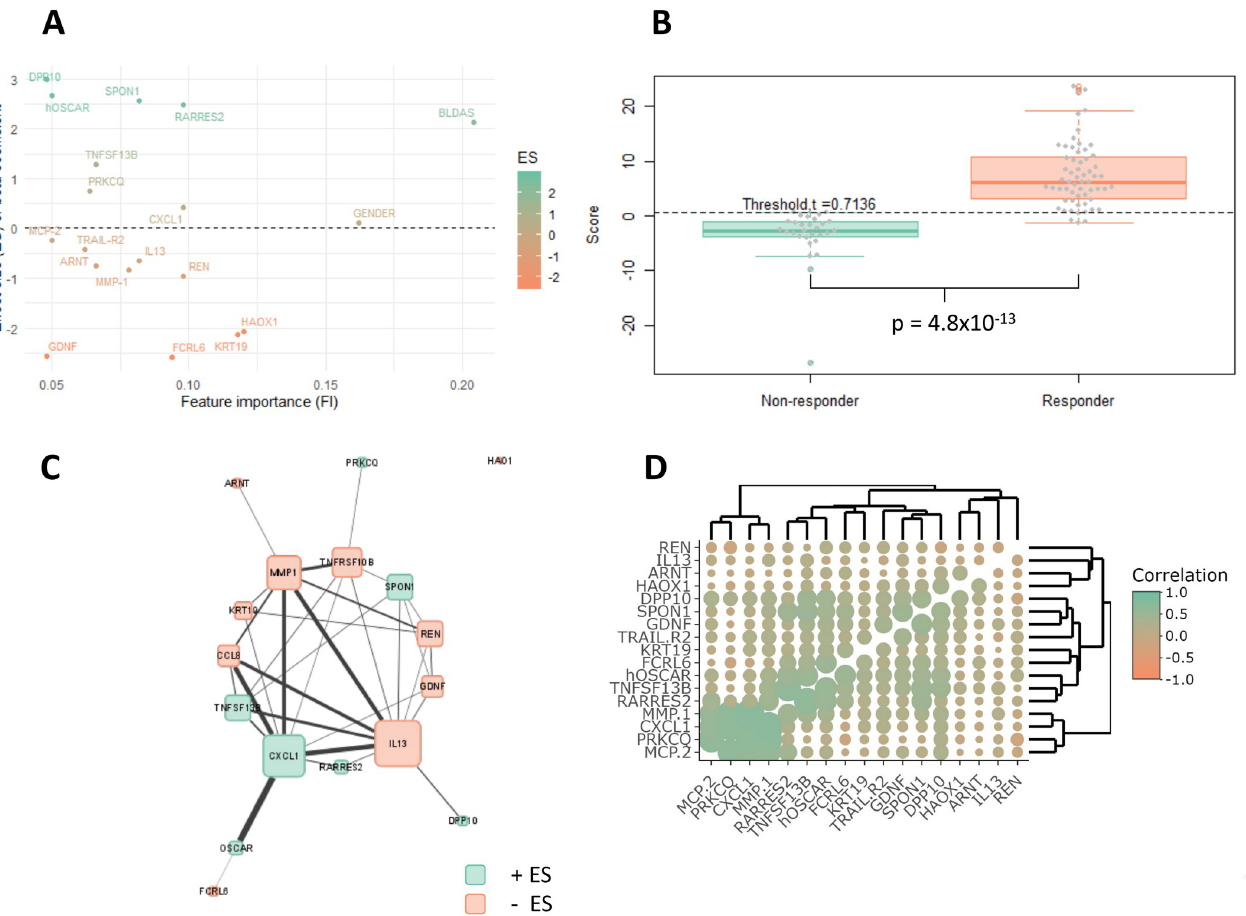
Fig 4. (A) Effect sizes (ES) or beta coefficients of regression vs. feature importance, i.e. fraction of 500 models, the feature appeared. (B) Boxplot of model score of each patient. NR = Non-responder, R = Responder. (C) Protein-Protein Interaction (PPI) network obtained from STRING database for 17 featured proteins. The size of the cell depicts the degree of the node i.e. number of connection with the other proteins, whereas the edge thickness represents the STRING database’s interaction scores. ES = effect size, as presented in Table 3. (D) Pearson’s correlation coefficient plot of 17 feature proteins. The size of circle depicts the -log 10 (p-value) of the